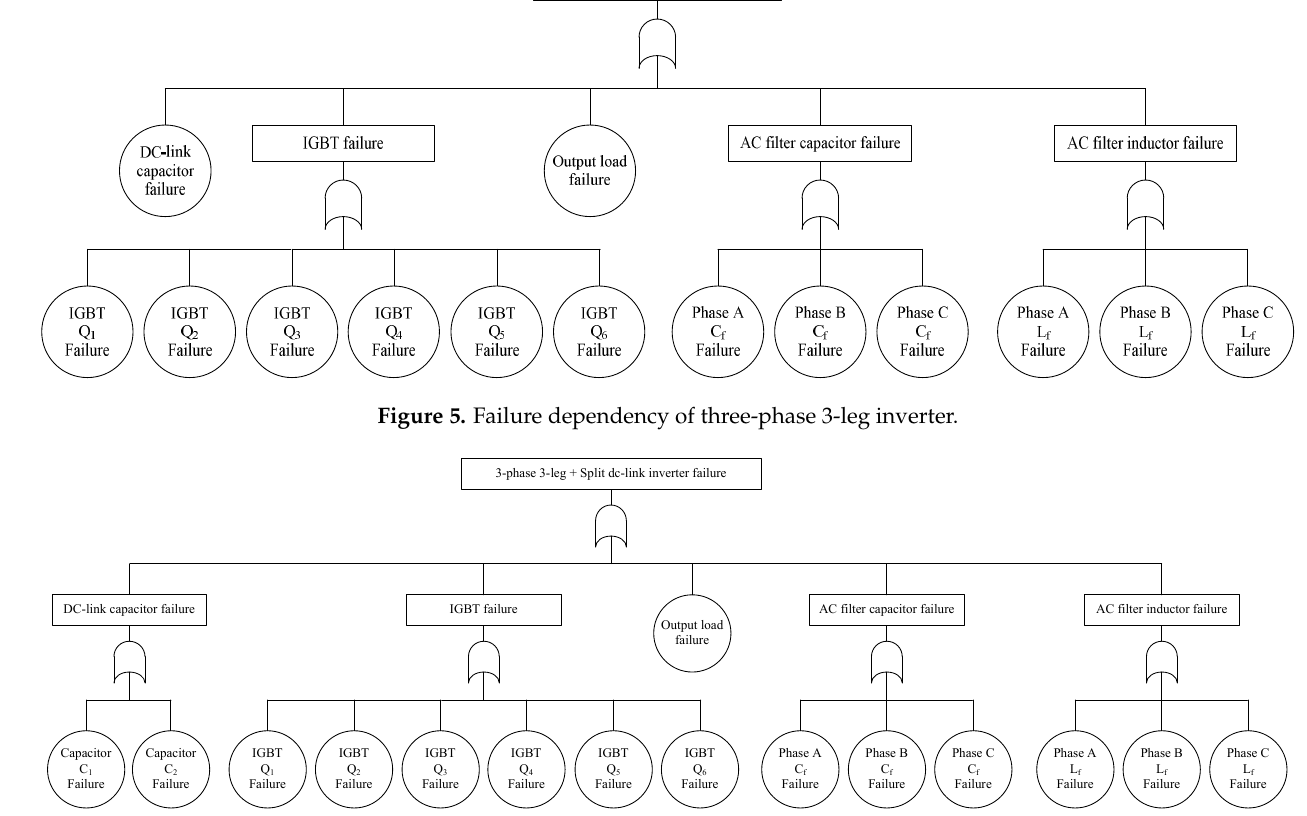
Figure 6. Failure dependency of three-phase 3-leg inverter with split DC-link capacitors.